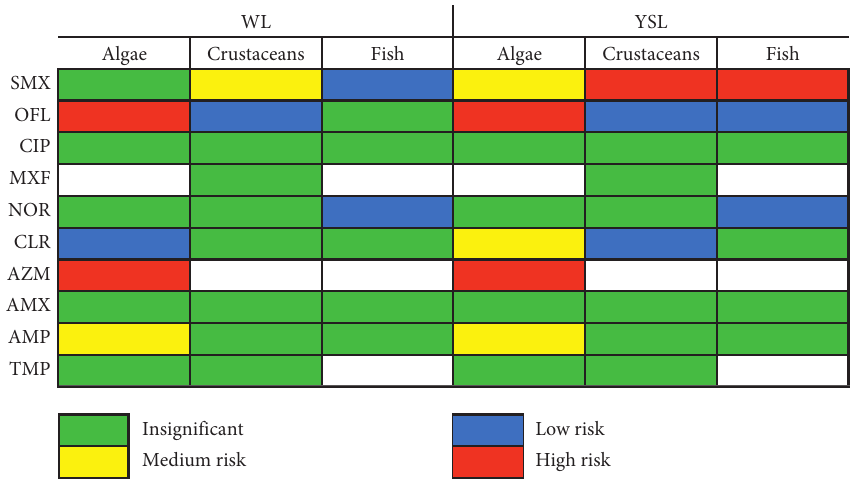
Figure 4: Ecological risks of ten antibiotics in West Lake and Yen So